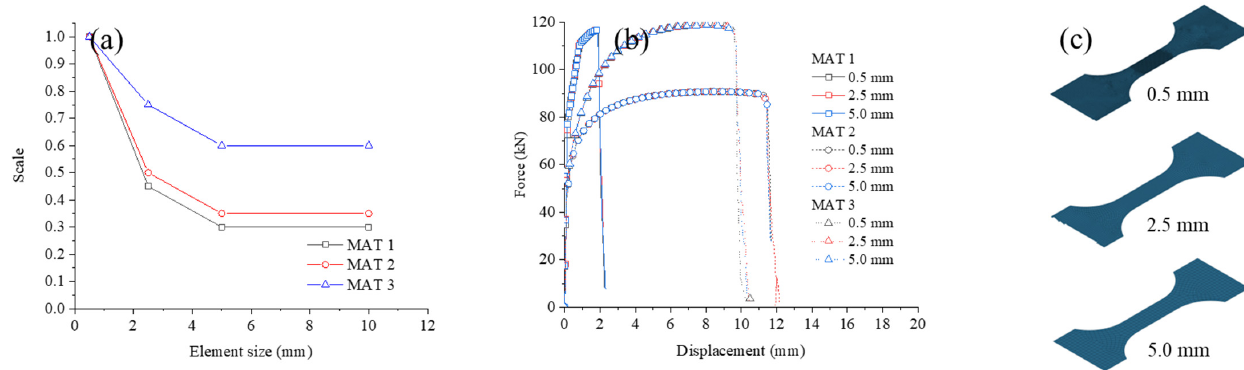
Figure 11. Shell-based model simulation vs. experiments for MAT 3 using GISSMO: ( a ) shear specimen, ( b ) tensile–shear specimen, ( c ) tensile specimen, ( d ) center hole specimen, ( e ) R20 notched specimen, and ( f ) R5 notched specimen.